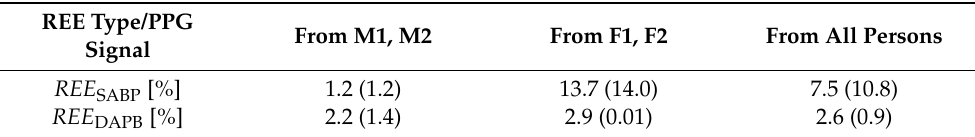
Table 2. Obtained summary mean REE values together with their std (in parentheses) separately for male/female and all tested persons.